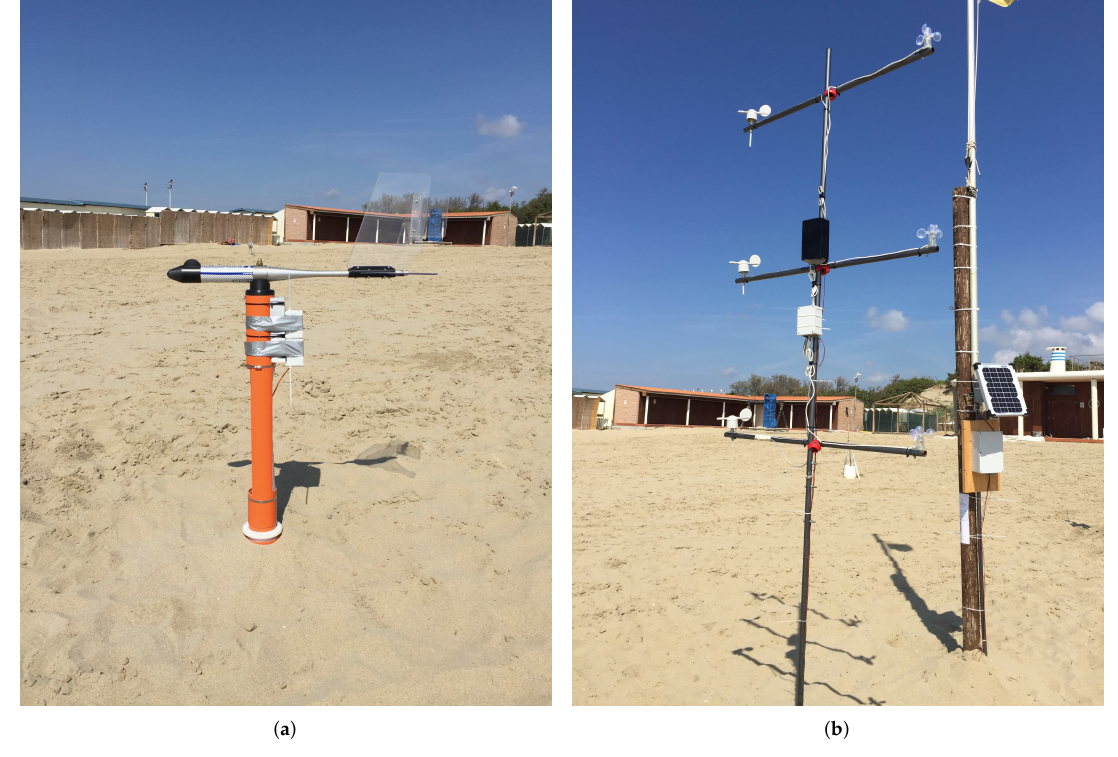
Figure 9. The nodes deployed on the Marina di Tirrenia beach, Pisa, Italy: ( a ) the sand trap and ( b ) the anemometer-anemoscope structure. The upper black box fixed in the middle of the anemometer-anemoscope structure houses the Coordinator. In the background it is possible to notice the 10 W solar cell powering the two